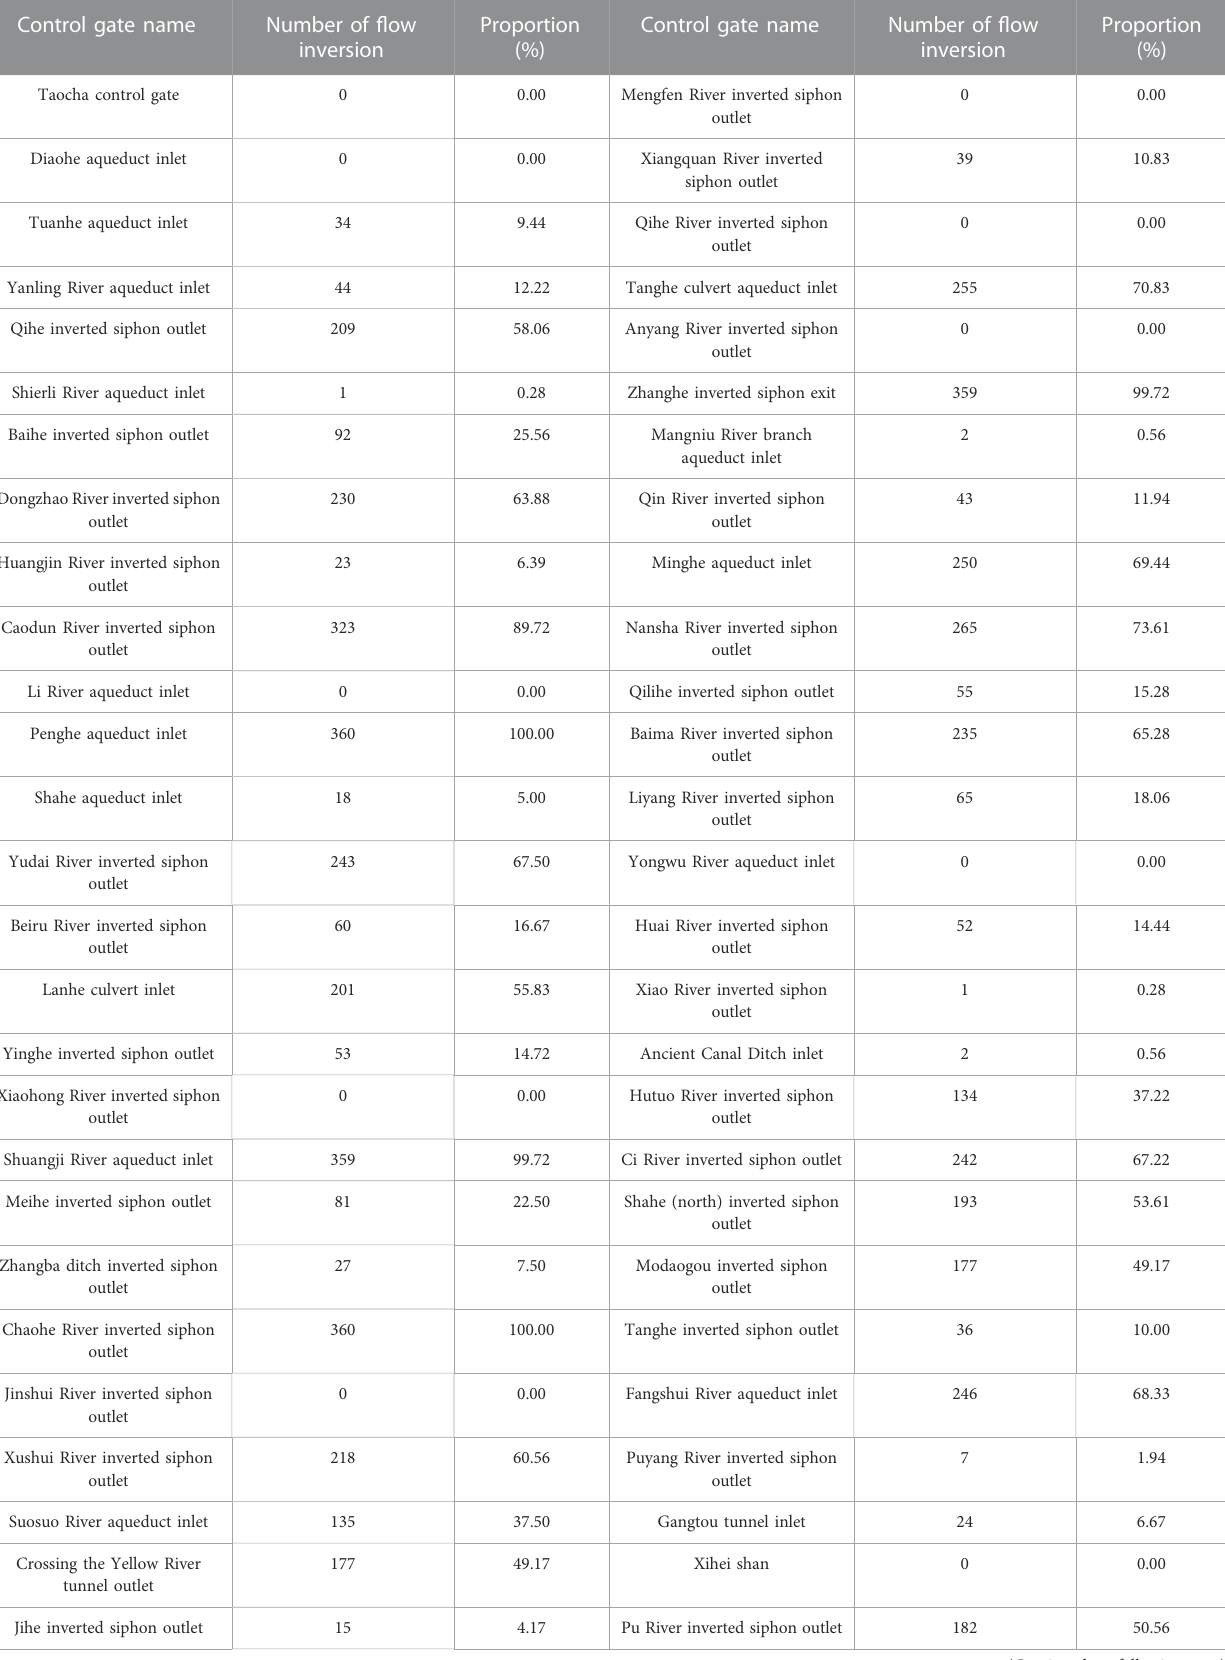
TABLE 1 Statistics of fl ow inversion of control gates along the whole of the middle route of the South-to-North Water Diversion Project